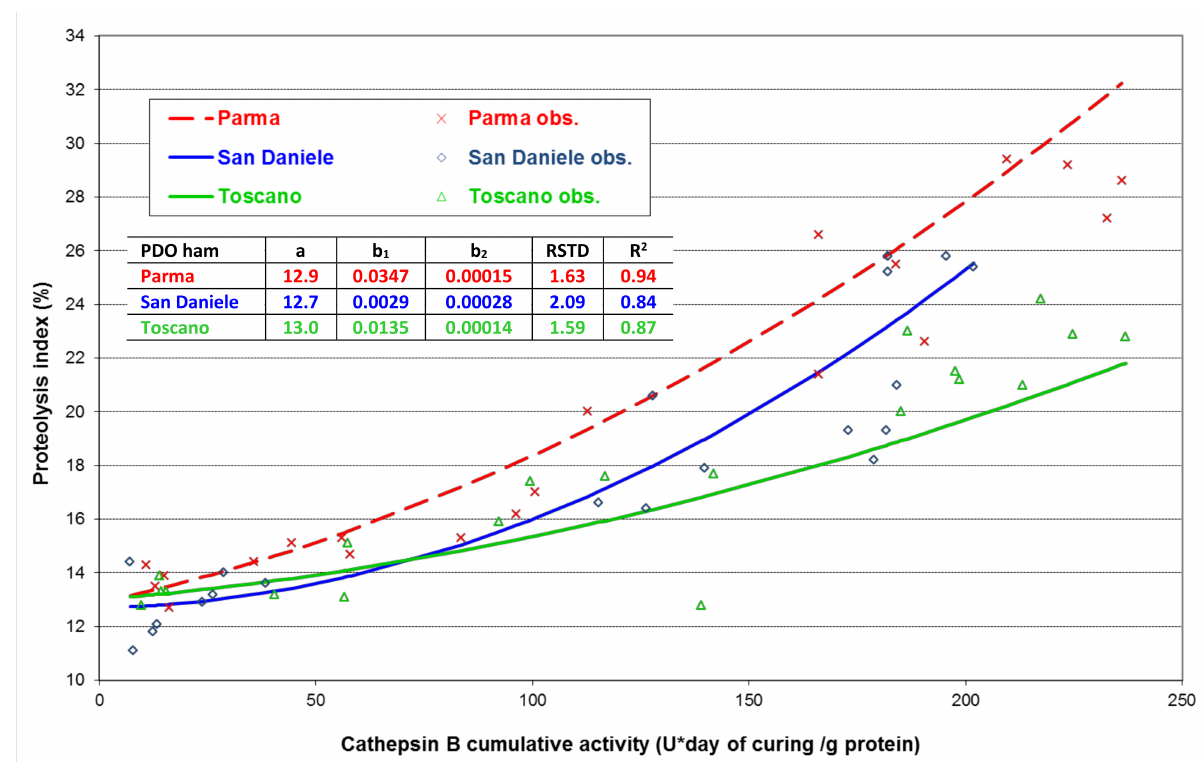
Figure 5. Relationship between proteolysis index (PI) and Cathepsin B cumulative activity (CBc) of Parma, San Daniele and Toscano PDO hams measured at five processing phases: individual observed values, obs., and second order polynomial regression lines, PI = a + b 1 CBc + b 2 CBc 2 . In table, regression coefficients (a, b 1 and b 2 ), residual standard deviation (RSTD), and coefficient of determination (R 2 ) of each PDO curve are